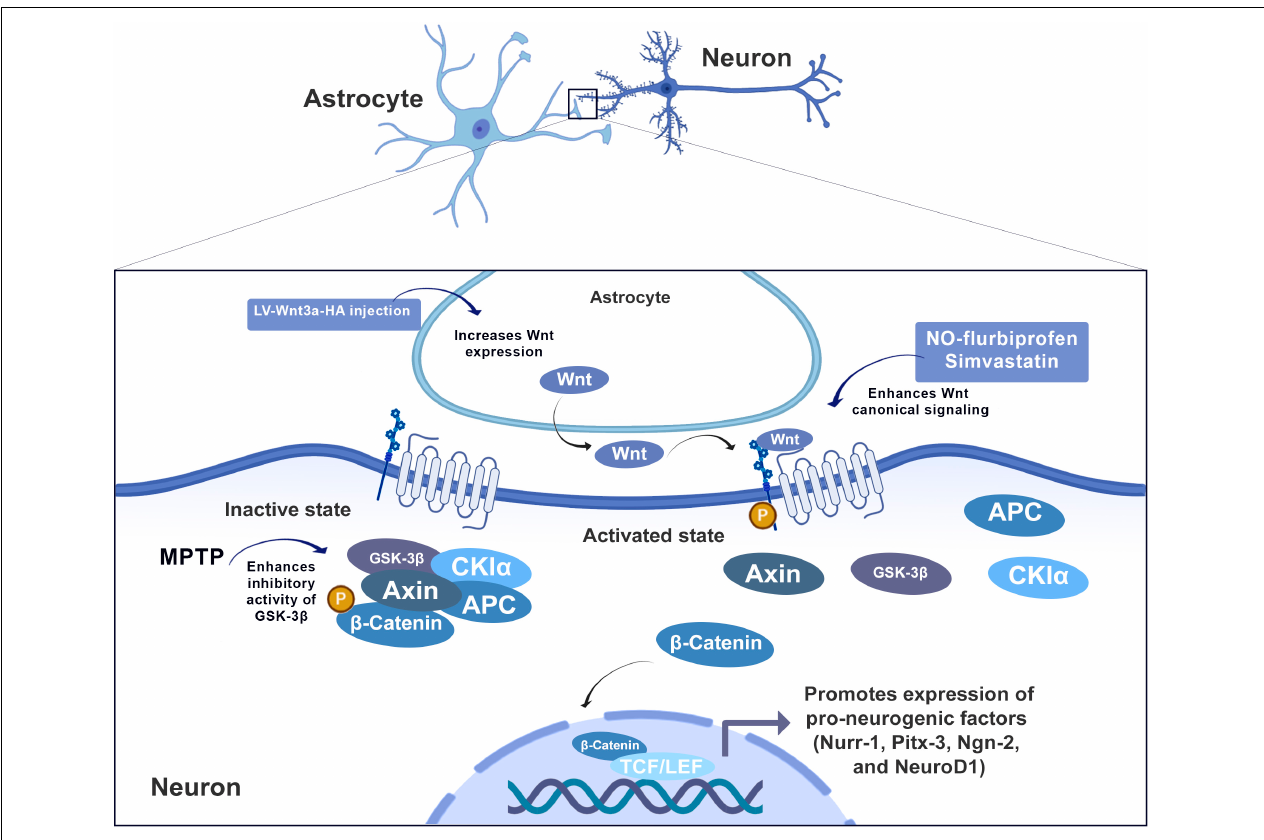
FIGURE 2 | The canonical pathway: Wnt binds to the transmembrane receptor Frizzled protein (Fz) and to the low-density protein co-receptor related to the lipoprotein receptor (LRP5/6) to activate the intracellular Dishevelled protein (Dvl), which therefore inhibits the activity of the complex composed of cytoplasmic glycogen synthase kinase 3 β (GSK-3 β ), adenomatous polyposis coli (APC), and Axin, leading to dephosphorylation, aggregation and nuclear translocation of β -catenin. Within the nucleus, β -catenin combines with T cell transcription factor (TCF)/lymphoid reinforcement factor (LEF) to form a complex, leading to transcriptional activation and expression of specific genes. Wnt/ β -catenin signaling enhanced neurogenesis by regulating proneural genes (Nurr-1, Pitx-3, Ngn-2, and